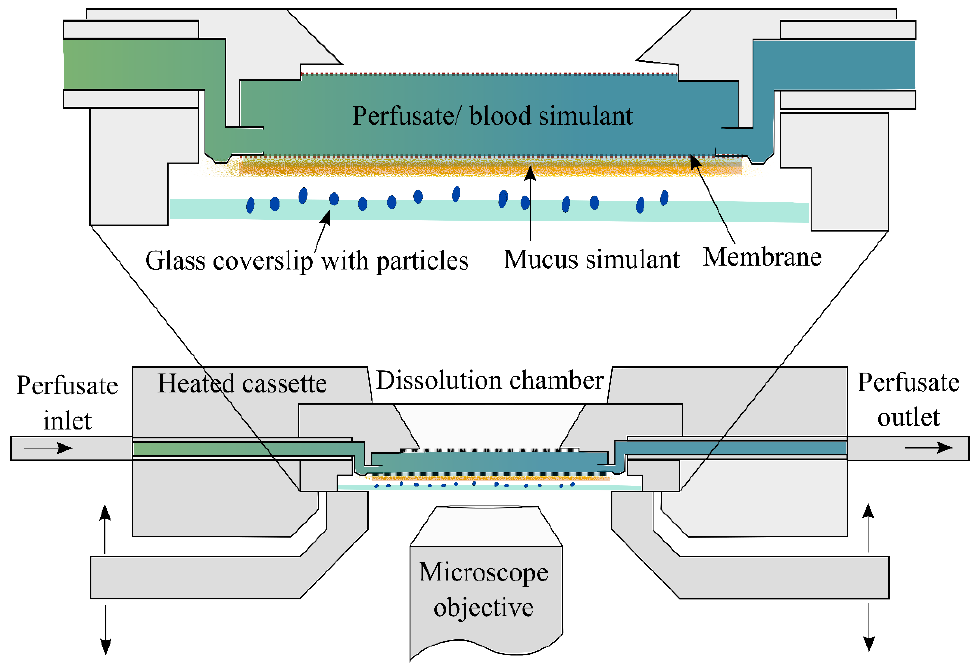
Figure 6. Schematic diagram of DissolvIt ® system. Reproduced with permission from Börjel et al., 2014 [59], Respiratory Drug Delivery 2014, Virginia Commonwealth University.